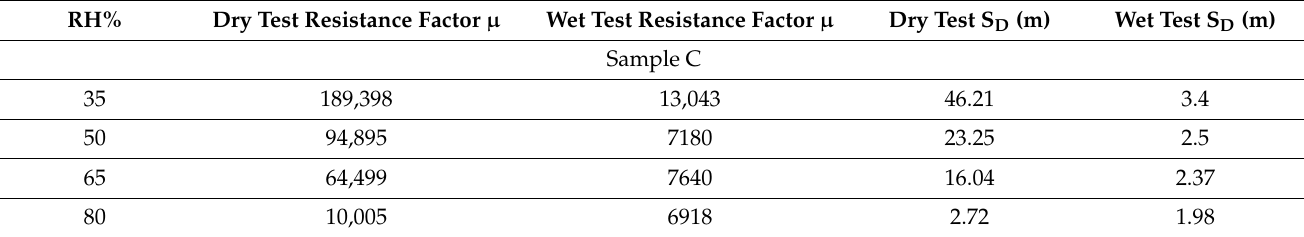
Table A1. Summary of average resistance factor µ and diffusion air layer thickness Sd of samples. RH% Dry Test Resistance Factor